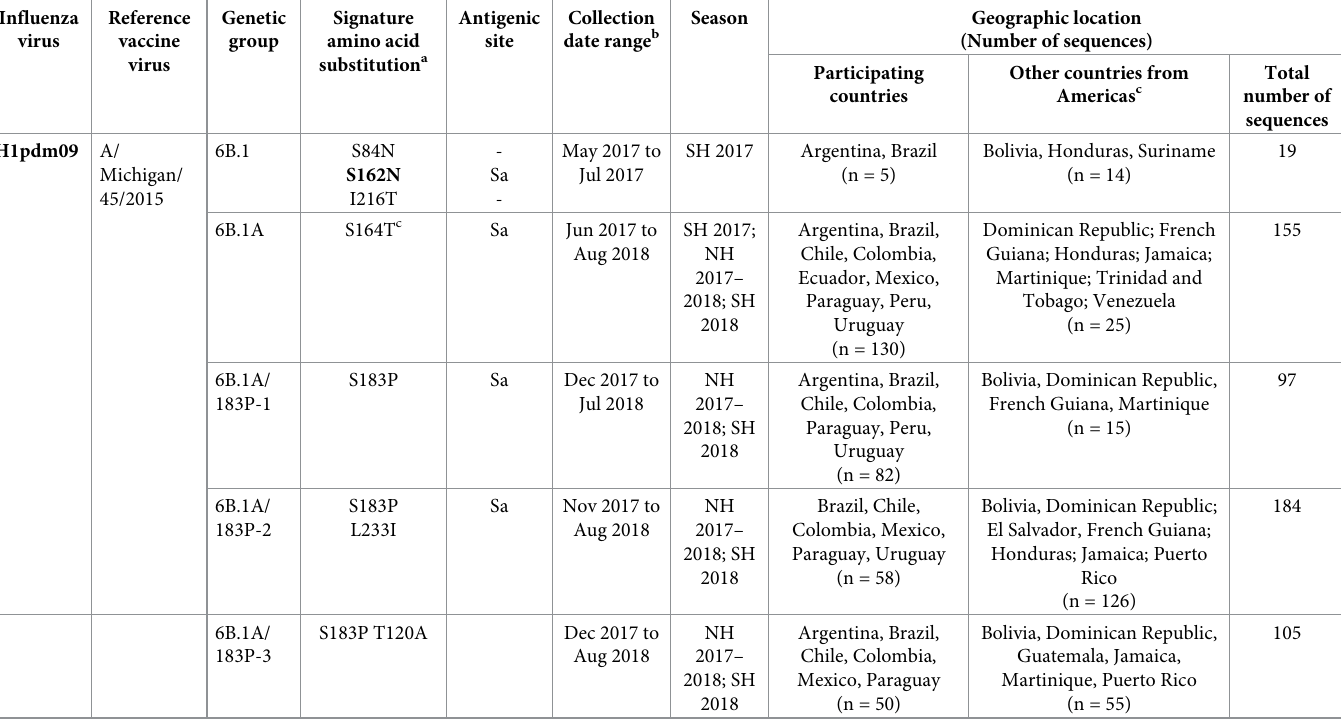
Table 2. Hemagglutinin amino acid substitutions compared to reference influenza virus vaccine strain—Latin America and the Caribbean, May 1, 2017 to October 26, 2018. Influenza Reference virus